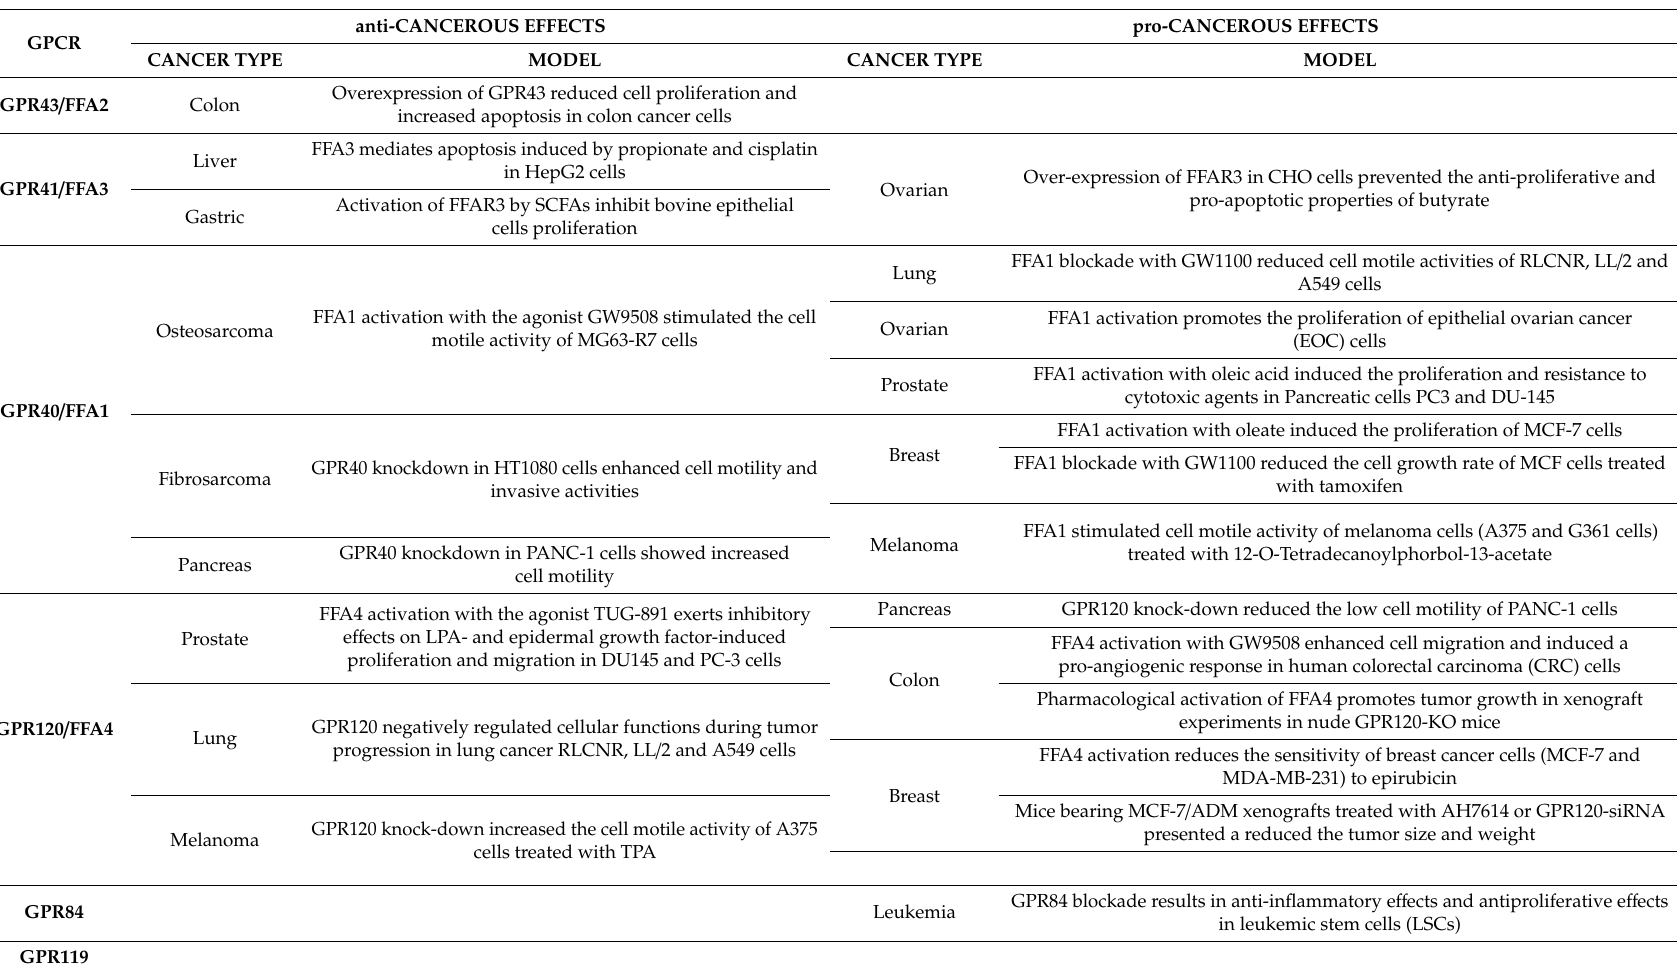
Table 3. Functional studies performed describing the role of the Free Fatty Acid Receptors (FFAR) in several types of cancers. This table includes the literature which demonstrates the anti-cancerous and pro-cancerous role of each Fatty Acid Receptor in both in vitro cells or in vivo with